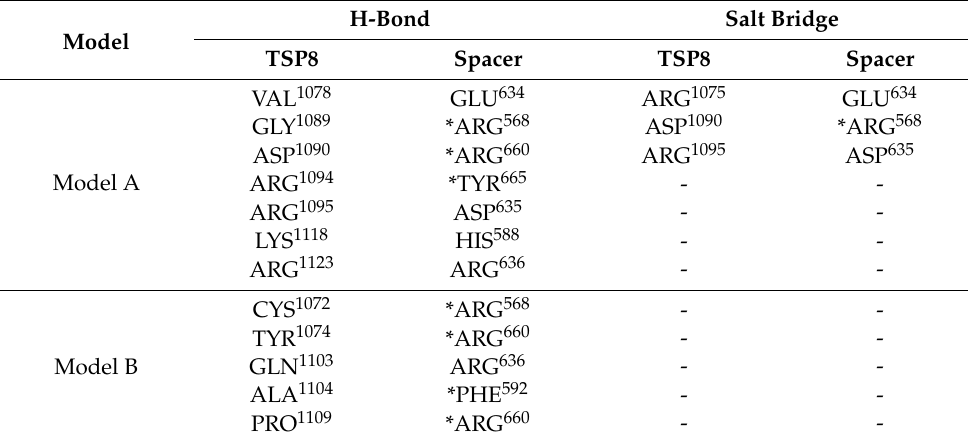
* Indicates residues in exosite-3 of the Spacer